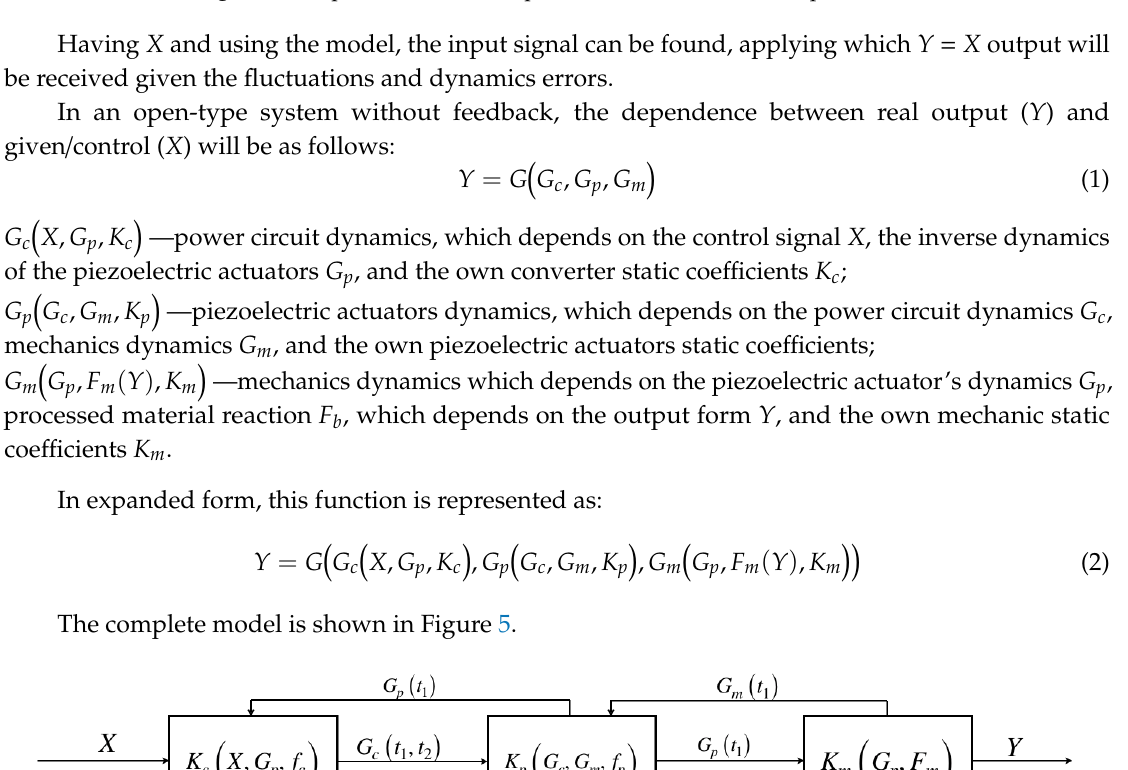
Figure 4. Simplified schematic representation of the intended procedure.